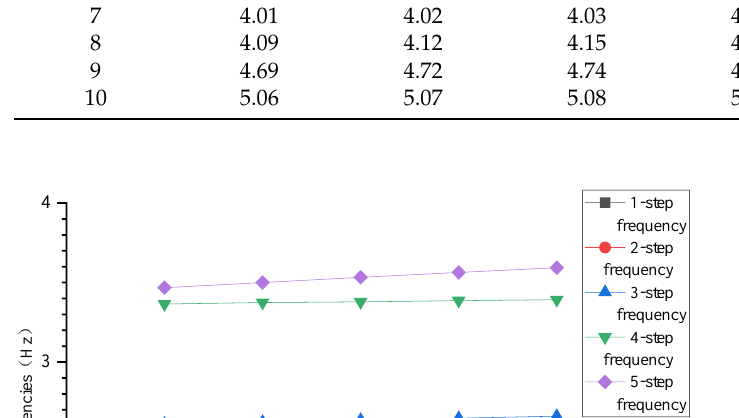
Table 8. Self-vibration frequencies (Hz) for different V-shaped pier stiffnesses of Structure I.